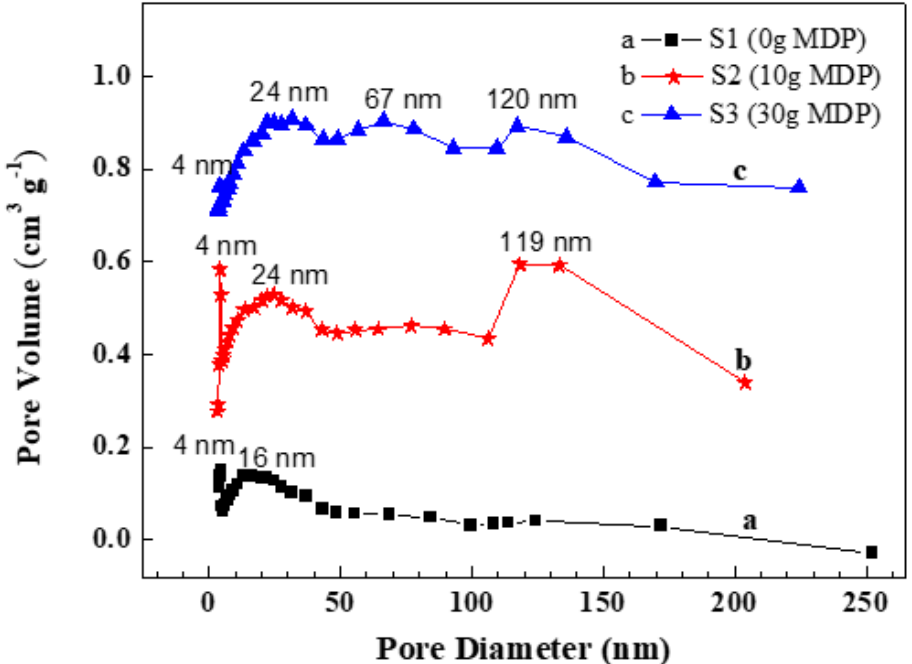
Figure 4. BJH pore size distribution of the nanocomposite samples prepared with different addi- tions of MDP: ( a ) S1 (0 g MDP), ( b ) S2 (10 g MDP), and ( c ) S3 (30 g MDP).